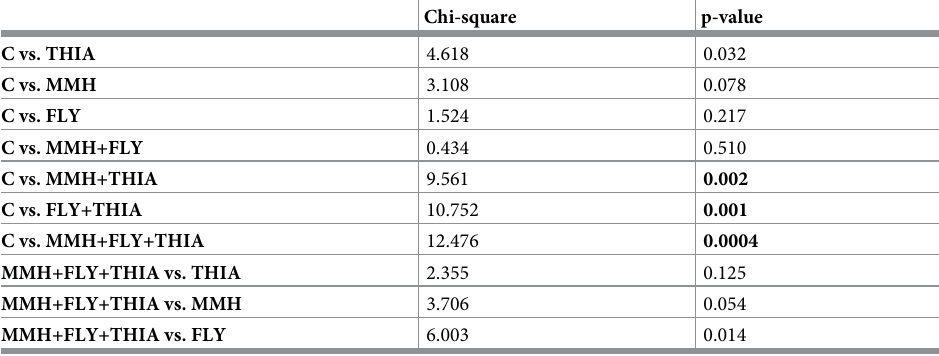
Table 1. Pairwise differences of honeybee worker survival rate 11 days post oral exposure to thiacloprid and E . faecalis and control